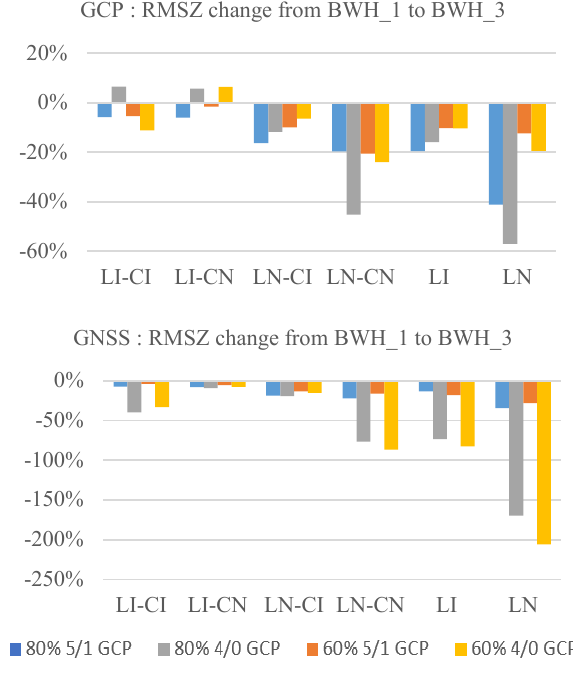
Figure 9. BWH_1 vs BWH_3 RMSZ change for each of the six configurations and side-lap percentage. Top: GCP case; bottom: GNSS case. Positive values correspond to BWH_1 being less accurate, negative ones to the